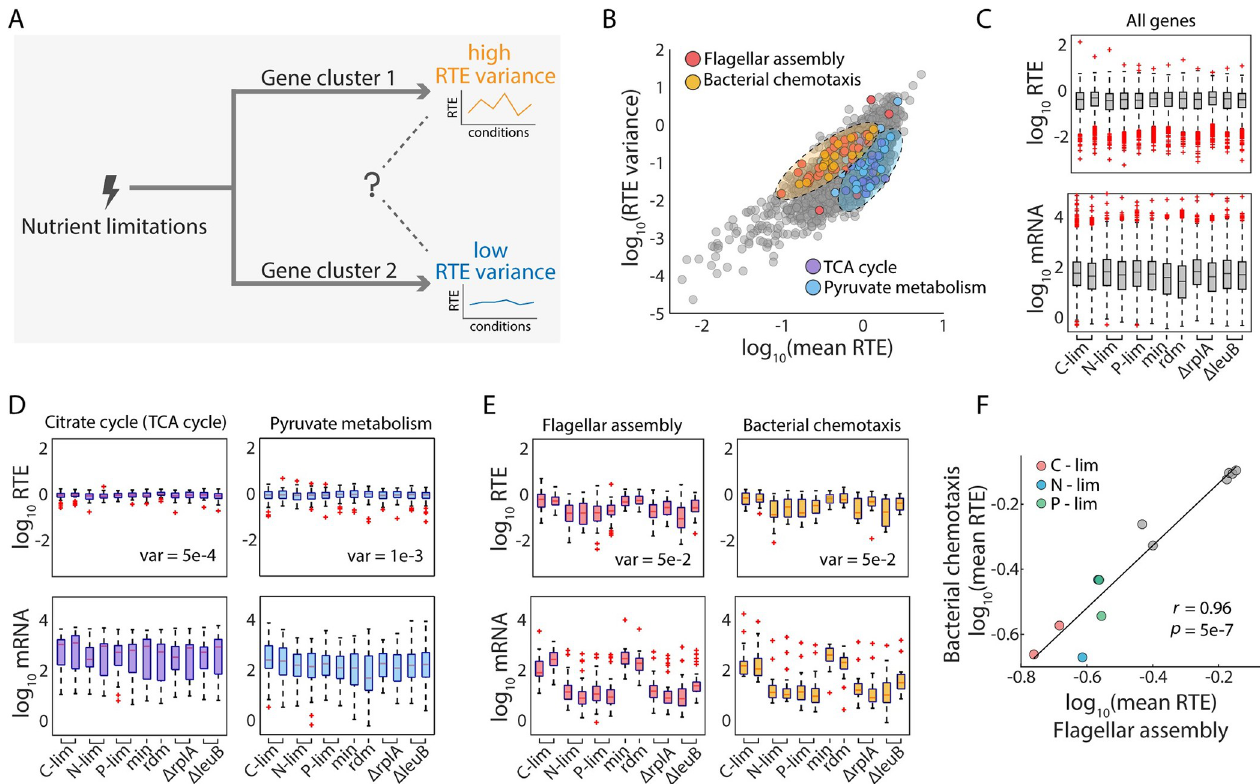
Fig 5. Pathways with similar gene expression patterns share similar gene functions. (A) Illustration of the question we investigated: when genes are classified by their cross-condition variance of RTE, what is the cause of this high-or-low variance classification? (B) Relationship between mean and variance of RTE across 12 conditions. Each dot represents one gene. Colored dots are genes involved in four selected pathways with different patterns of translational regulation. (C) Distribution of RTEs (upper) and mRNA levels (lower) of all genes, under the 12 different conditions. (D) Distribution of RTEs (upper) and mRNA levels (lower) for genes involved in TCA cycle (left panel) and those involved in pyruvate metabolism (right panel). (E) Distribution of RTEs (upper) and mRNA levels (lower) for genes involved in flagellar assembly (left panel) and those involved in chemotaxis (right panel). (F) Correlation of mean RTE across 12 conditions between genes involved in flagellar assembly and bacterial